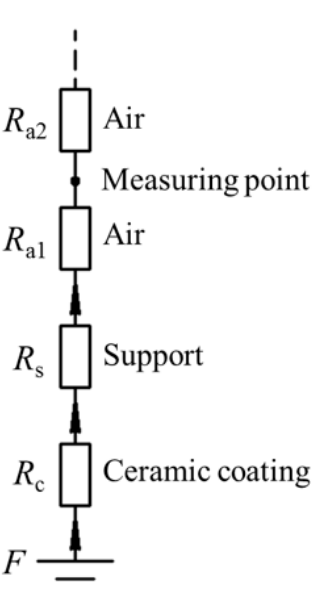
Figure 3. The model of the MFL sensing principle for steel pipe.